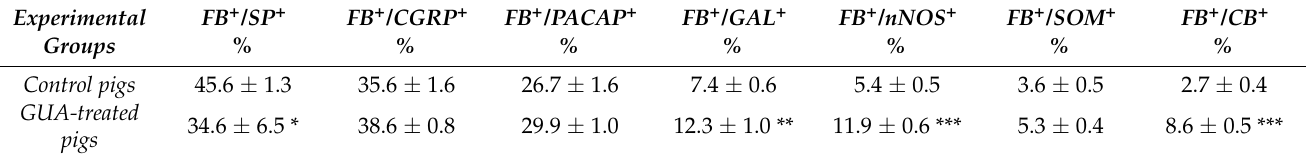
Table 2. Percentages of FB + neuronal subpopulations in DRG of the control and GUA-treated animals, which simultaneously expressed SP, CGRP, PACAP, GAL, nNOS, SOM, or CB. Data expressed as mean ± SD. Asterisks mark statistically